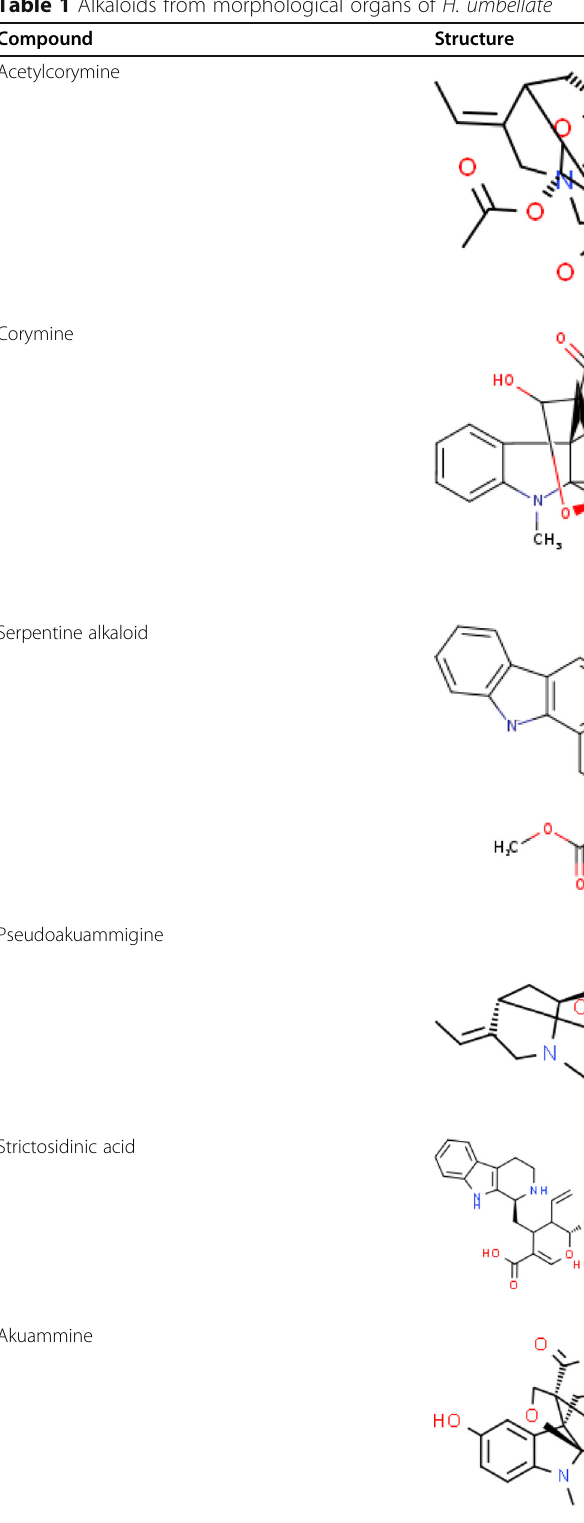
Table 1 Alkaloids from morphological organs of H.